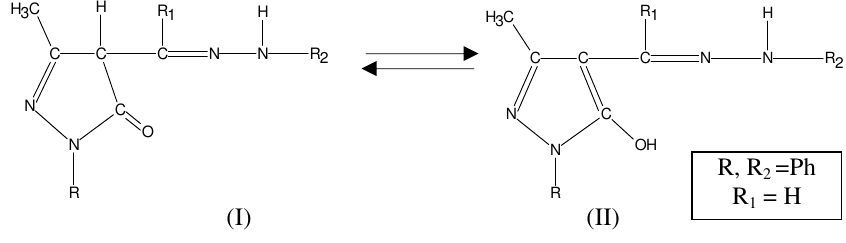
Figure 1. 4-Carboxaldehyde-1-phenyl-3-methyl-2-pyrazolin-5-one with phenylhydrazine Results and